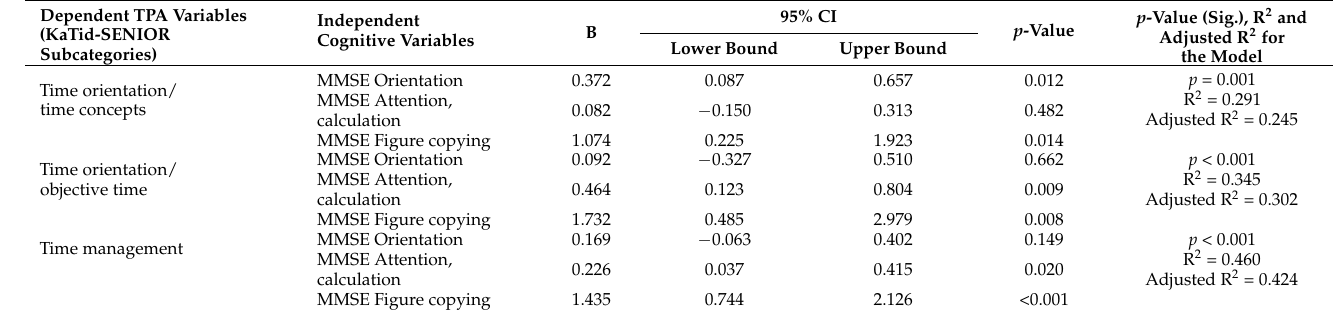
Table 4. Multiple linear regression models of time orientation/time concepts (KaTid-Senior part